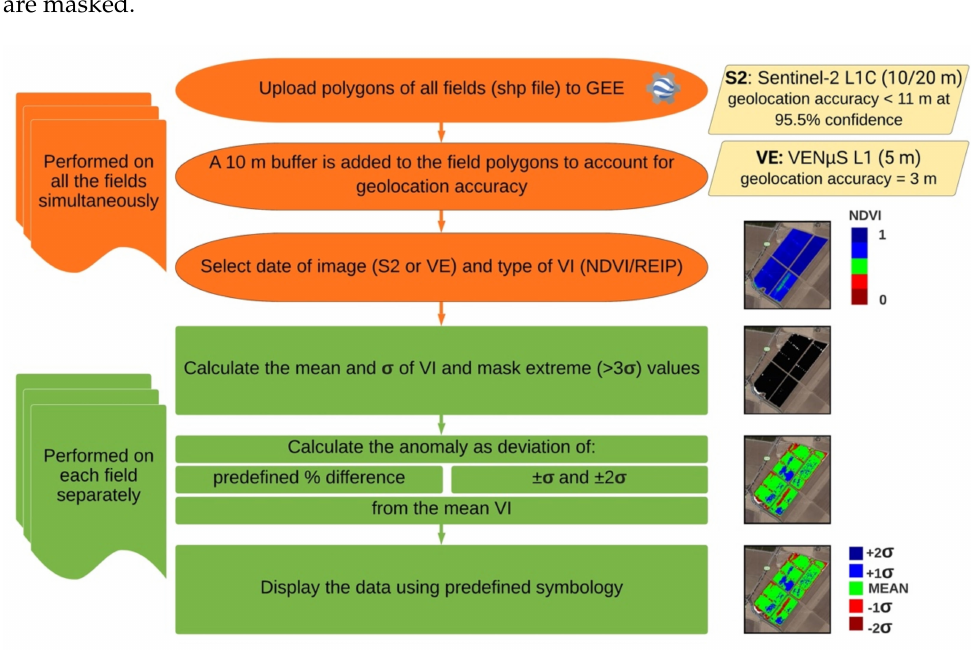
Figure 3. Anomaly Explorer app